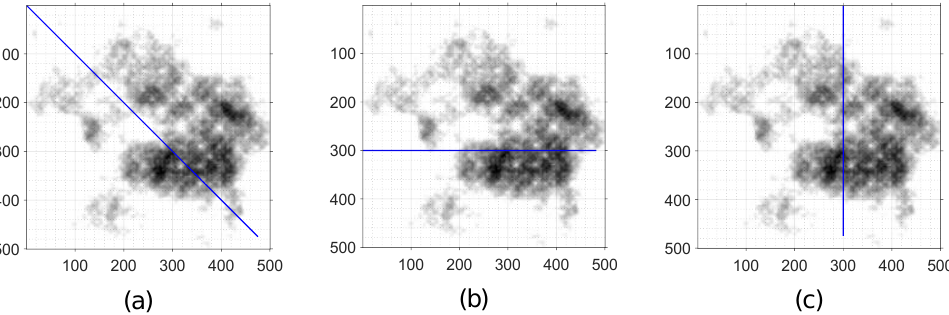
Figure 10. Three case studies of MC on studied PV array (The blue lines show directions of the MC). ( a ) Case 1. ( b ) Case 2. ( c ) Case 3.